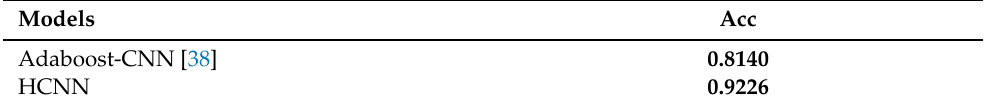
Table 5. The experimental analysis of Adaboost-CNN and HCNN on the CIFAR-10 dataset.